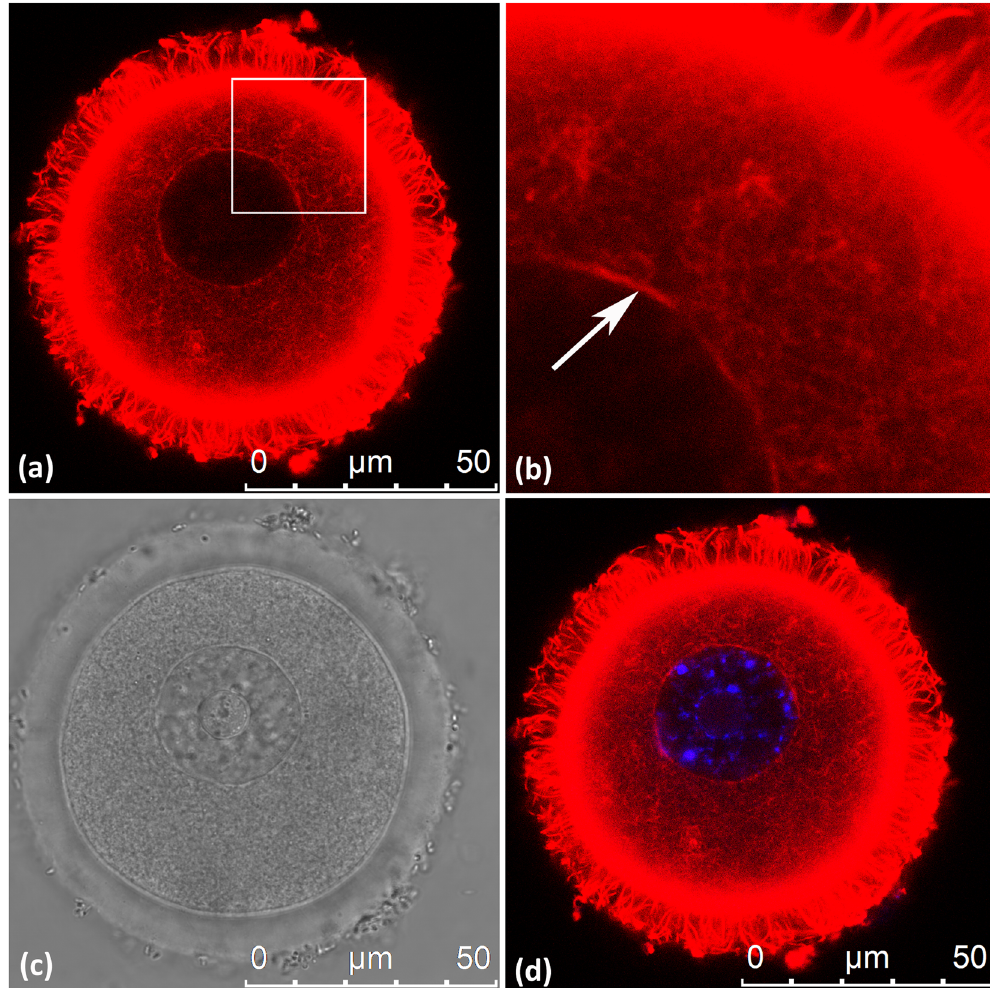
Figure 3. Nuclear actin rim surrounds the GV of mouse oocytes. GV oocytes were fixed and processed as described in ‘Experimental Procedures’. Actin filaments were stained with Tritc-Phalloidin (red) diluted in PBS, containing 0.1% Triton X-100 and 3% BSA. DNA was stained with Hoecst (blue). ( a ) Tritc-Phalloidin; ( b ) Enlargement of the area marked in (a); ( c ) Bright field; ( d ) Merge of Tritc-Phalloidin and Hoecst. White arrow points at the actin